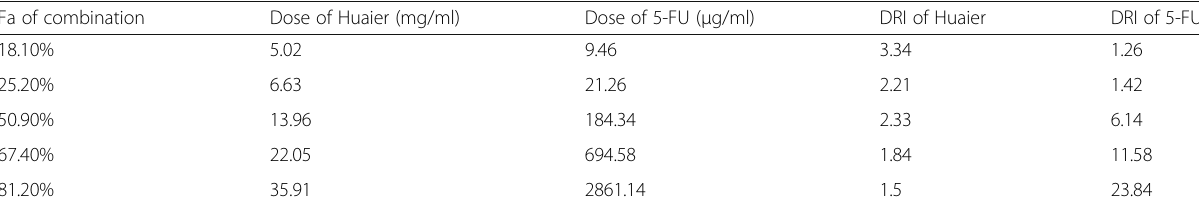
Table 2 The dose of Huaier or 5-FU alone to achieve the same fraction affected level of in-combination and the dose reduction index (DRI) values for Huaier combined with 5-FU after 24 h Fa of combination Dose of Huaier (mg/ml) Dose of 5-FU ( μ g/ml)